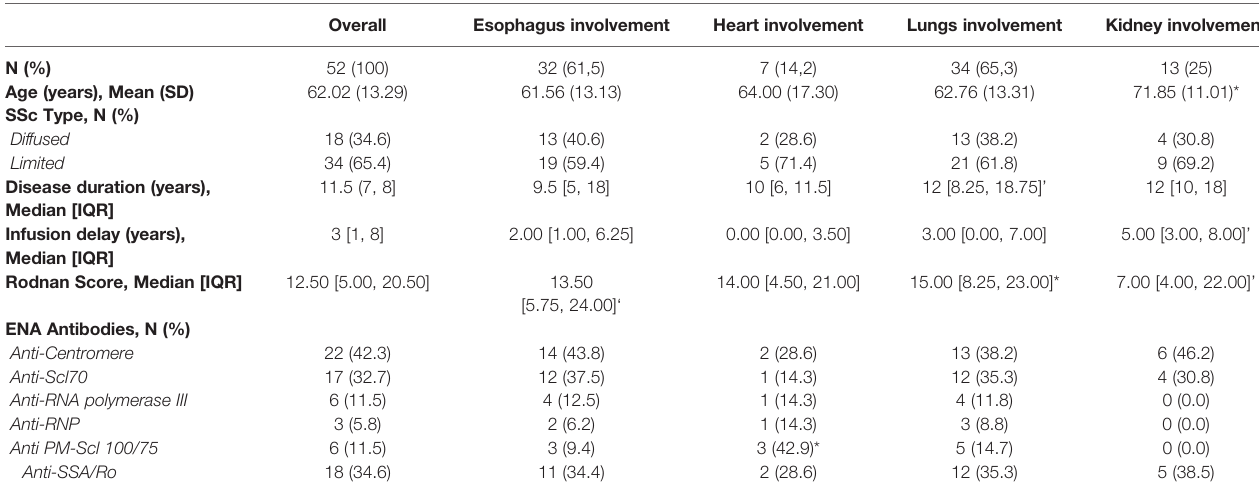
TABLE 1 | Patient characteristics, overall and by organ